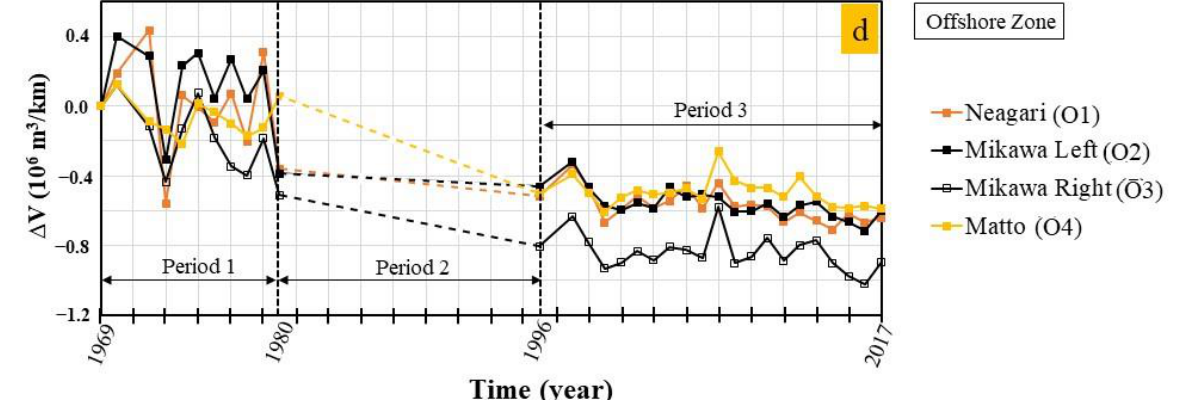
Figure 5. Cumulative temporal variation in the sediment volumes on the Ishikawa coast and the Tedori River from 1969 to 2017: ( a ) cumulative temporal variation of sediment volume along the coast and river, ( b ) coastal sediment volumes in the surf and offshore zones, ( c ) surf zone sediment volume in each cell, and ( d ) offshore zone sediment volume in each cell.